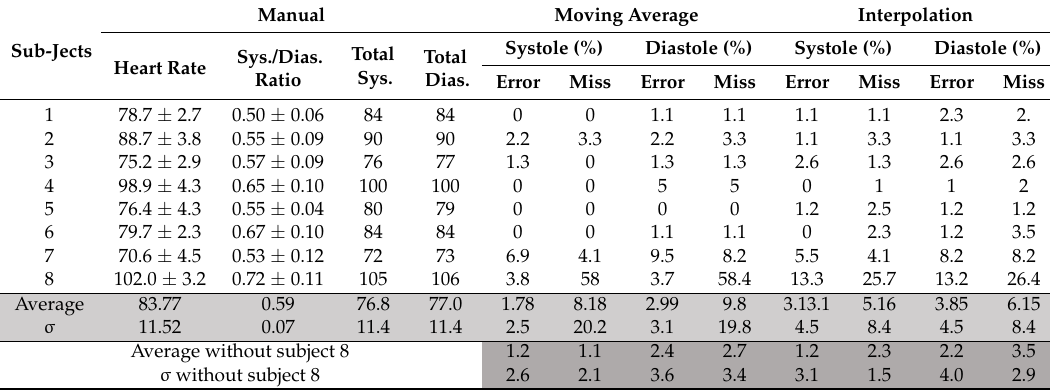
Table 7. The error and missing rates of moving average threshold and interpolation algorithms with total acceleration (Equation (3)) on eight